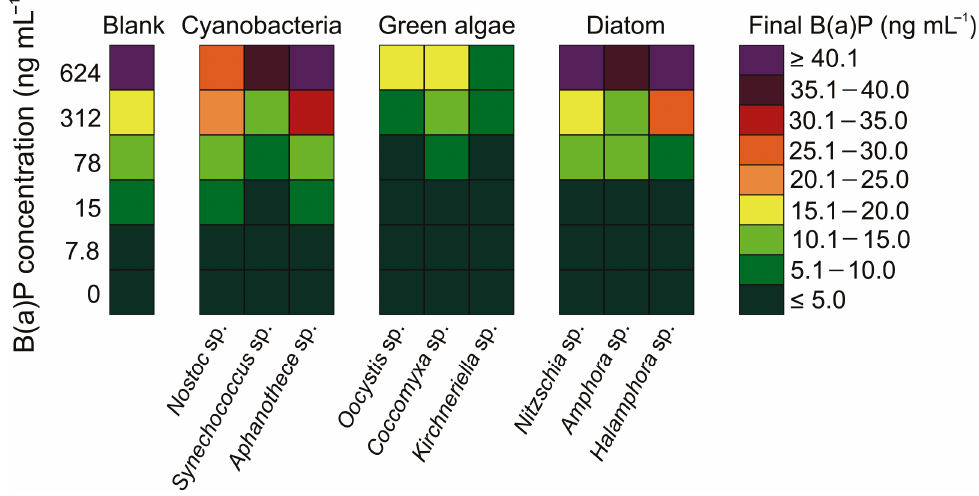
Figure 4. The final concentration of benzo(a)pyrene after 7 days of exposure for individual cyanobacteria and microalgae.